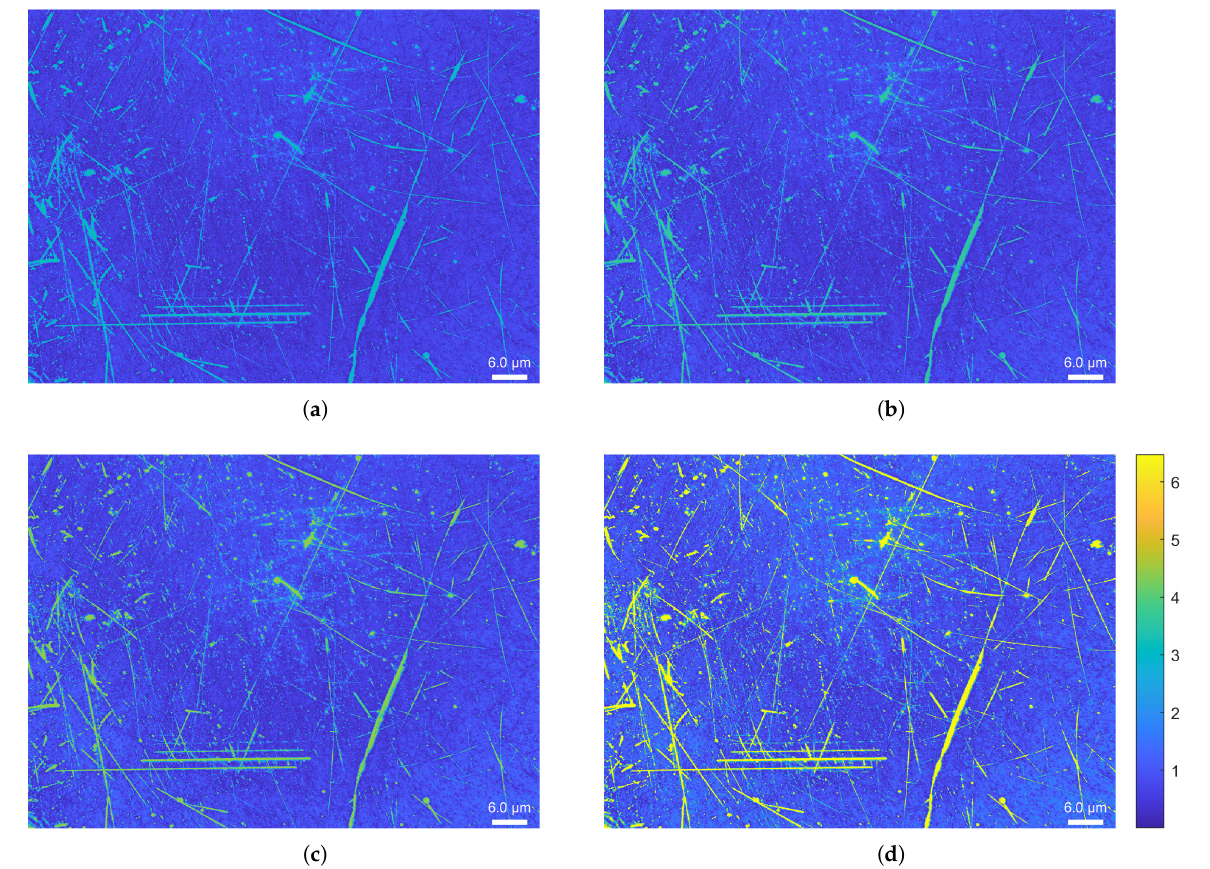
Figure 7. Level factor saliency map estimated with the statistics descriptors calculated from an RTI acquisition of a watch dial with micro-scratches: ( a ) Saliency map SP 100% ; ( b ) Saliency map SP 99.9% ;